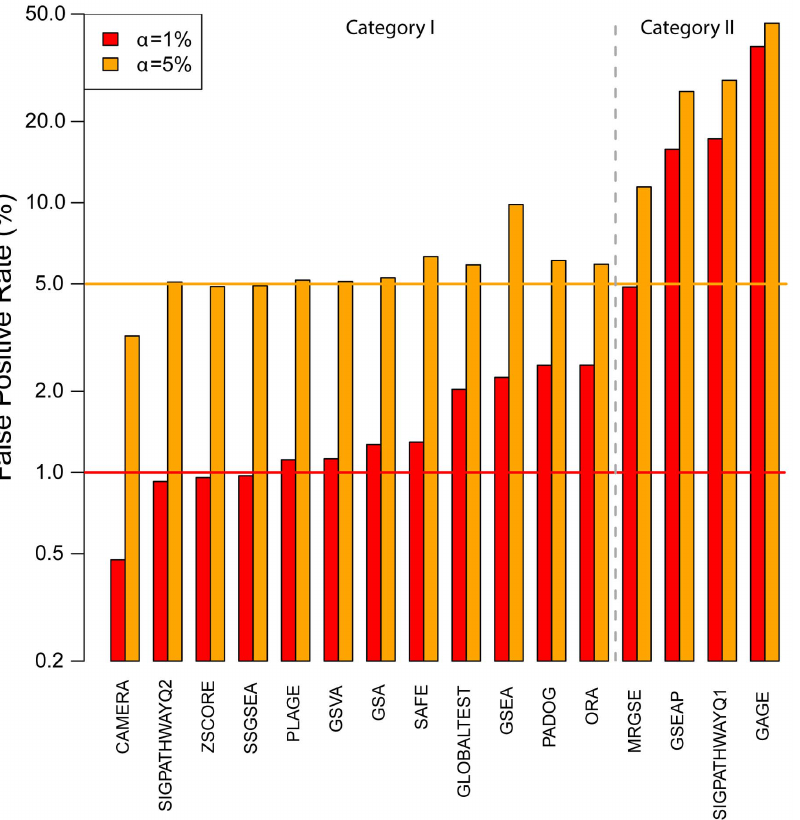
Figure 3. False positive rates produced by 16 gene sets analysis methods. The null hypothesis is simulated by analyzing phenotype permuted versions of the original datasets. The percentage of all pathways found significant at different significance levels ( a ) is reported for each method with a vertical bar. The horizontal lines denote the expected levels of false positives at each a level. Note the logarithmic scale.